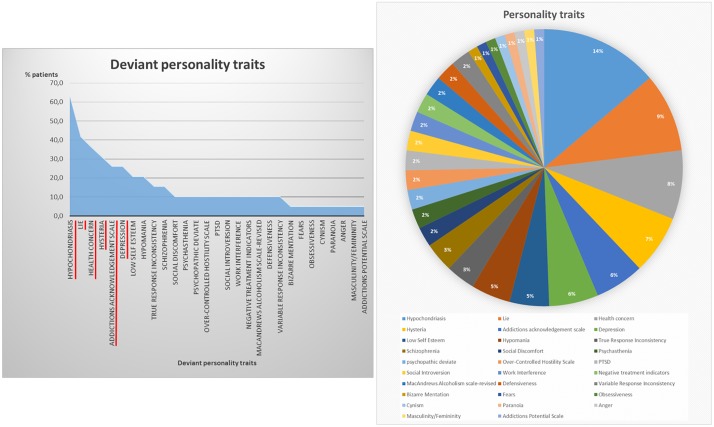
Personality traits.Figure shows the representation of deviant personality traits amongst participants.